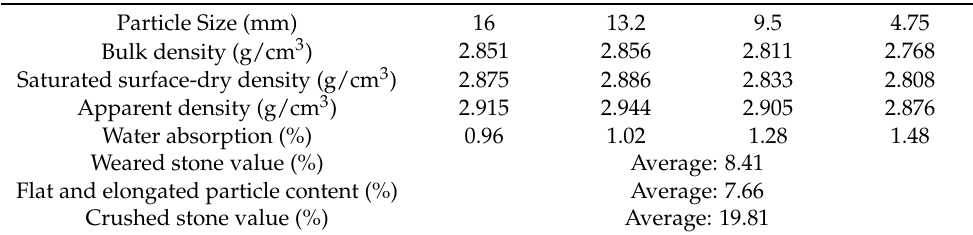
Table 2. Performance parameters of coarse